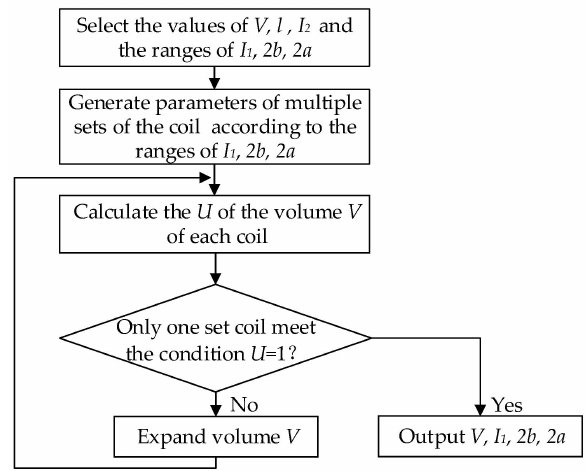
Figure 7. Coil parameters optimization flow chart.